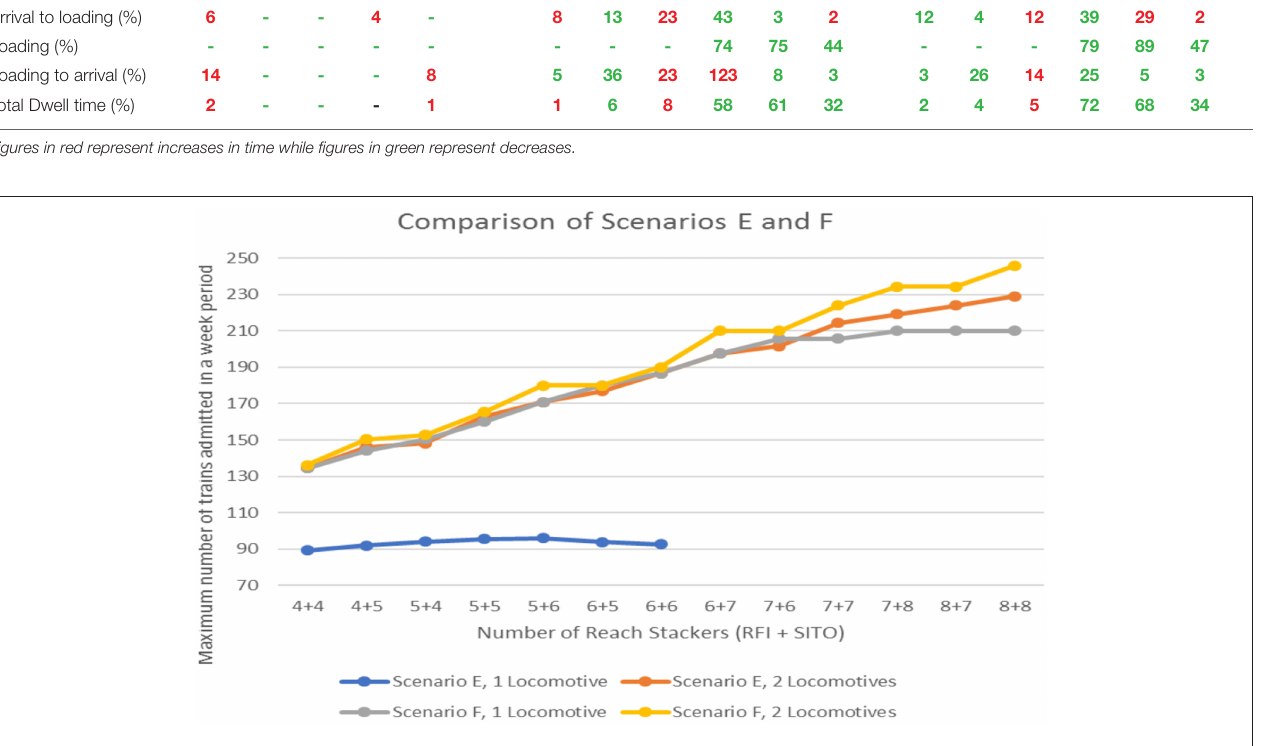
FIGURE 5 | Different throughputs in scenarios E and